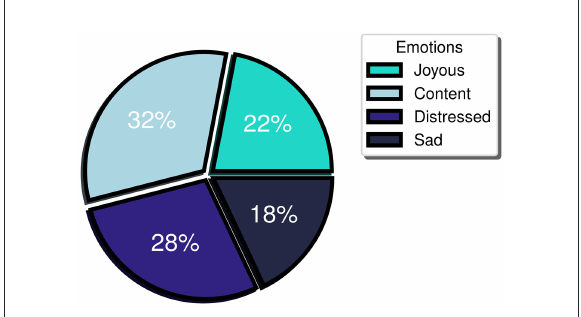
FIGURE3 Distribution of emotions logged by type of